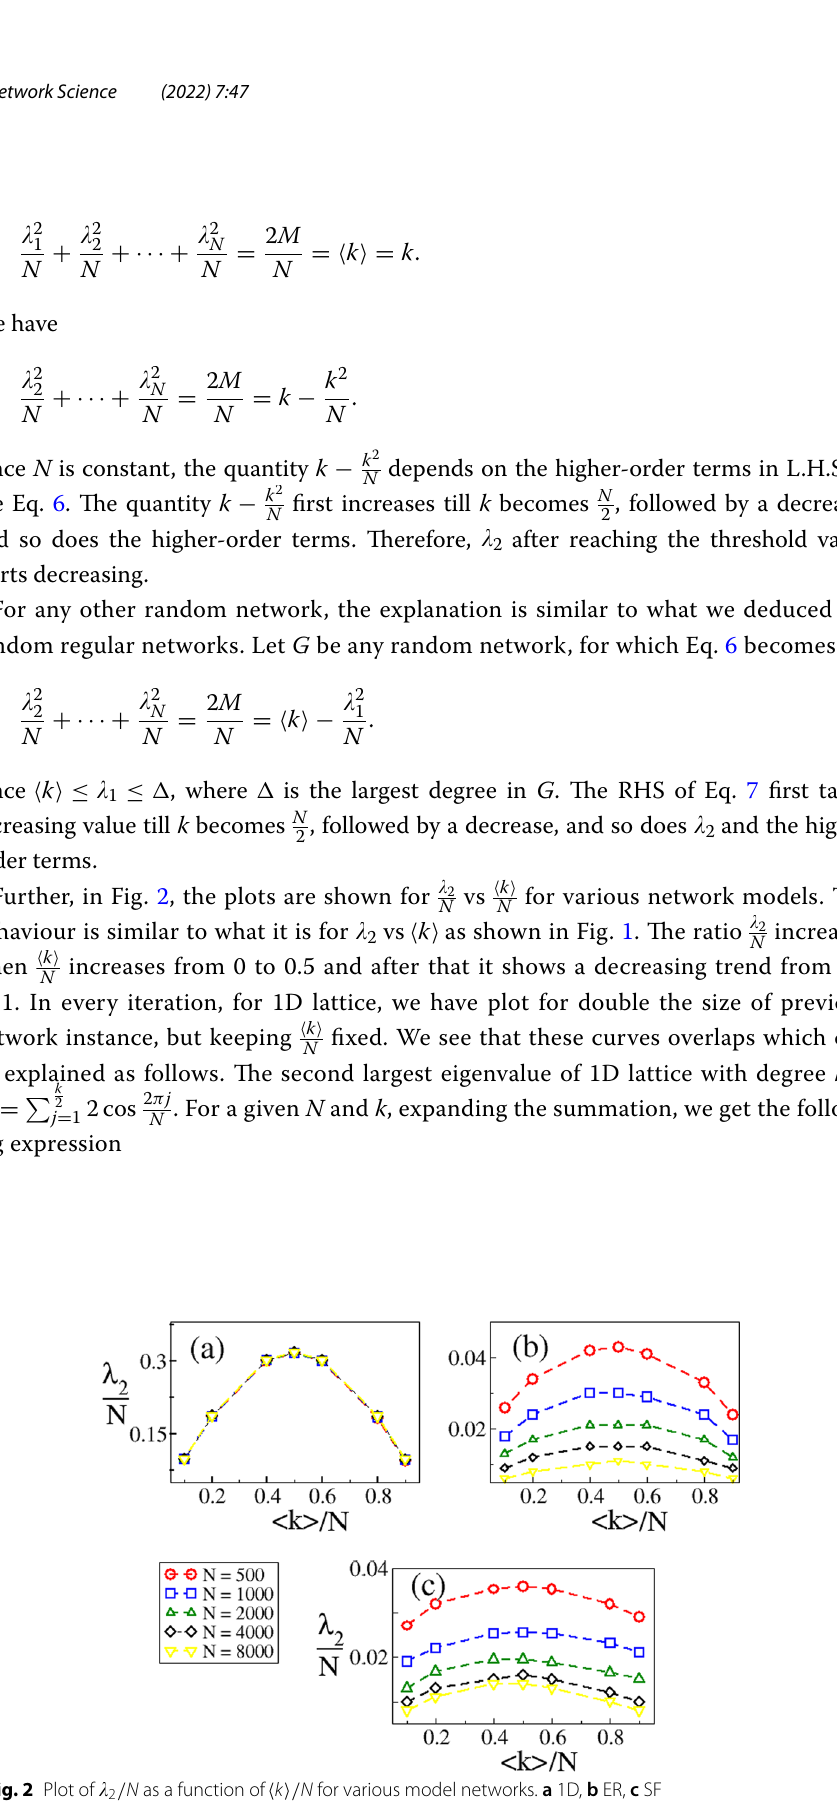
Fig. 2 Plot of (cid:31) 2 / N as a function of